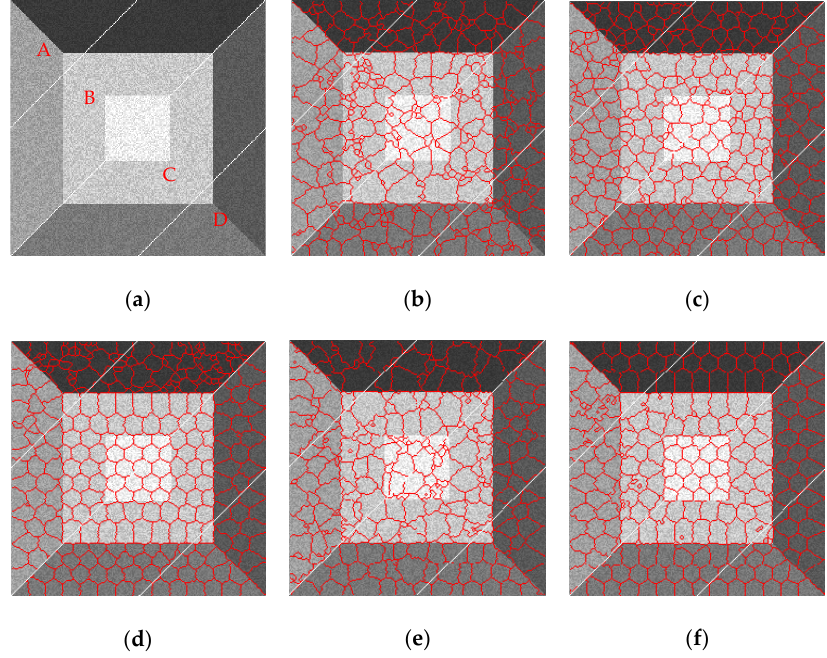
Figure 10. Resulting superpixels with K set to 240, v set to 0.075, and m set to three, six, nine, and 12 for regions A, B, C, and D, respectively. ( a ) Original; ( b ) SLIC; ( c ) PILS; ( d ) LBSLIC; ( e ) PBSLIC; ( f ) PSDSD.